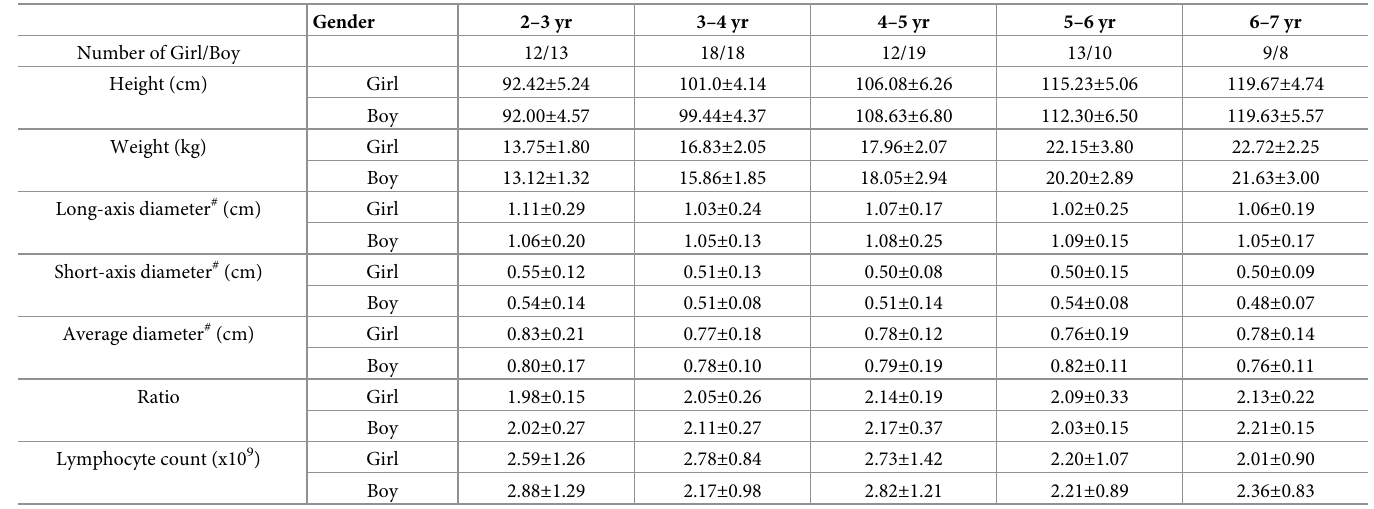
Table 1. Characteristics of children included.